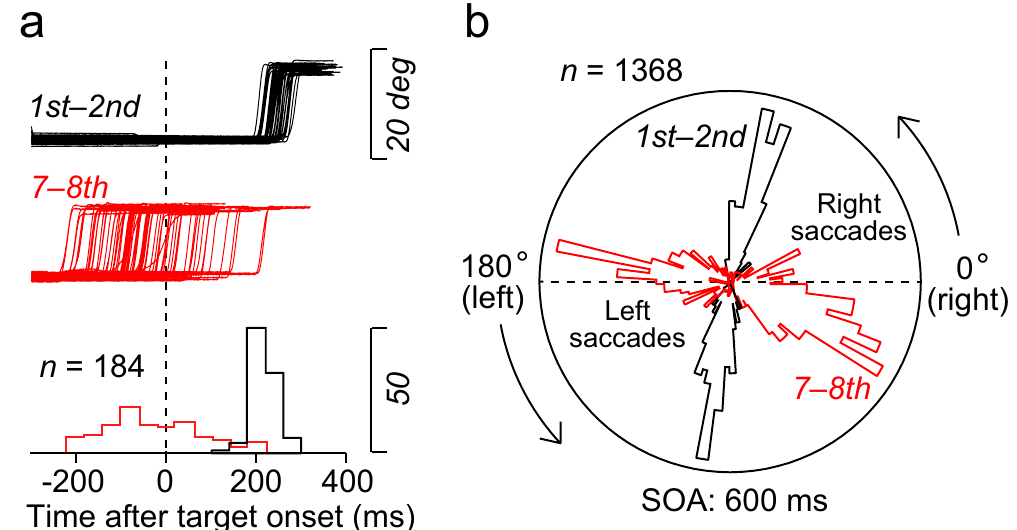
Figure 2. Reactive and predictive saccades in representative experiments. ( a ) Eye position traces of the 1st–2nd (black) and 7–8th (red) rightward saccades for trials with a 600-ms SOA in a single experimental session. Data are aligned with the target onset (vertical dashed line), and lower histograms summarize saccade latencies. Note that while the initial two saccades in the sequence were reactive, the later saccades were often synchronized with (or even preceded) target appearance. ( b ) Circular histogram of saccade timing for 5 experimental sessions in monkey K. 0° and 180° indicate the timing of right and left target onset, respectively. Each cluster of the histogram is normalized for the peak